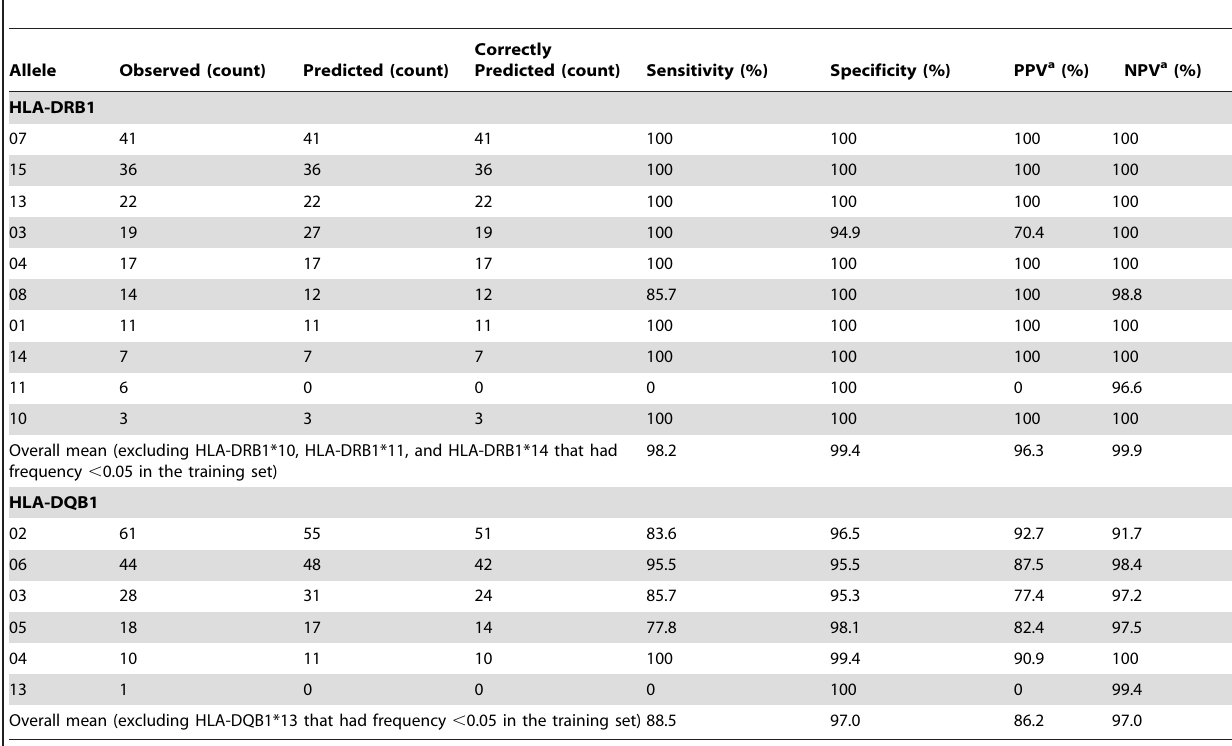
Table 2. Sensitivity, specificity, positive predictive value and negative predictive value of the prediction in the test set at intermediate (two-digit) HLA allele resolution.